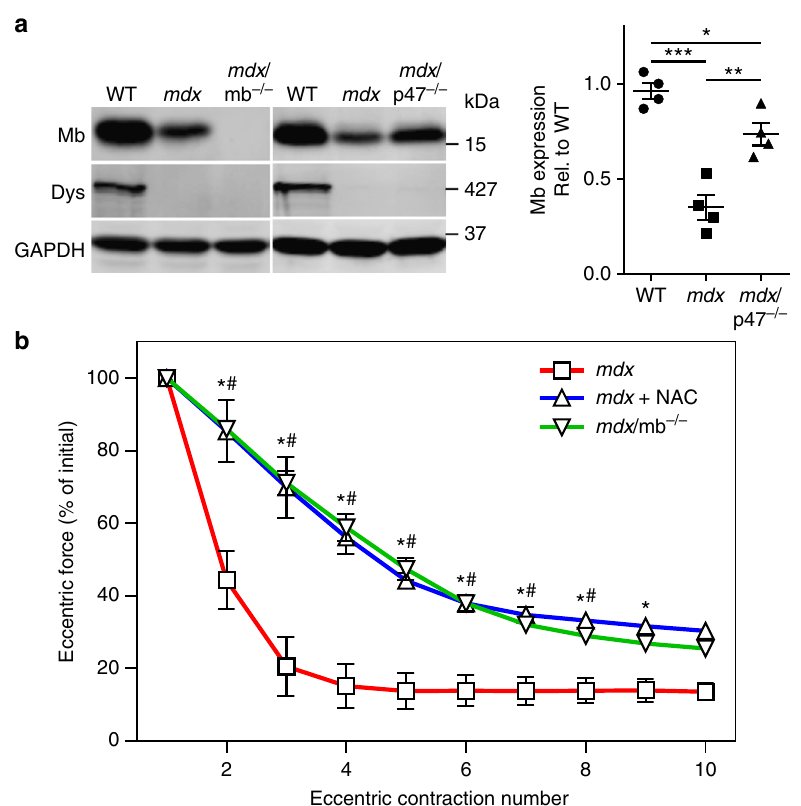
Fig. 3 Genetic ablation of myoglobin partially protects mdx muscle from eccentric contraction-induced force loss. a Immunoblot analysis demonstrated the absence of myoglobin in mdx /mb – / – muscle, that myoglobin levels are decreased in mdx , and that myoglobin levels are partially restored in mdx /p47 – / – gastrocnemius muscle; n = 4 for each genotype. * P < 0.05, ** P < 0.01, *** P < 0.001; one-way ANOVA. b EDL muscles isolated from mdx and mdx /mb – / – mice, or mdx muscles treated with 20 mM N-acetylcysteine (NAC) were subjected to 10 eccentric contractions and the forces measured expressed as a percentage of the force generated during the fi rst eccentric contraction; n = 4 for WT and mdx + NAC; n = 9 for mdx /mb – / – ; * mdx + NAC signi fi cantly different from mdx ( P ≤ 0.05); # mdx /mb – / – signi fi cantly different from mdx ( P ≤ 0.05); two-way ANOVA. Throughout, error bars represent means ±